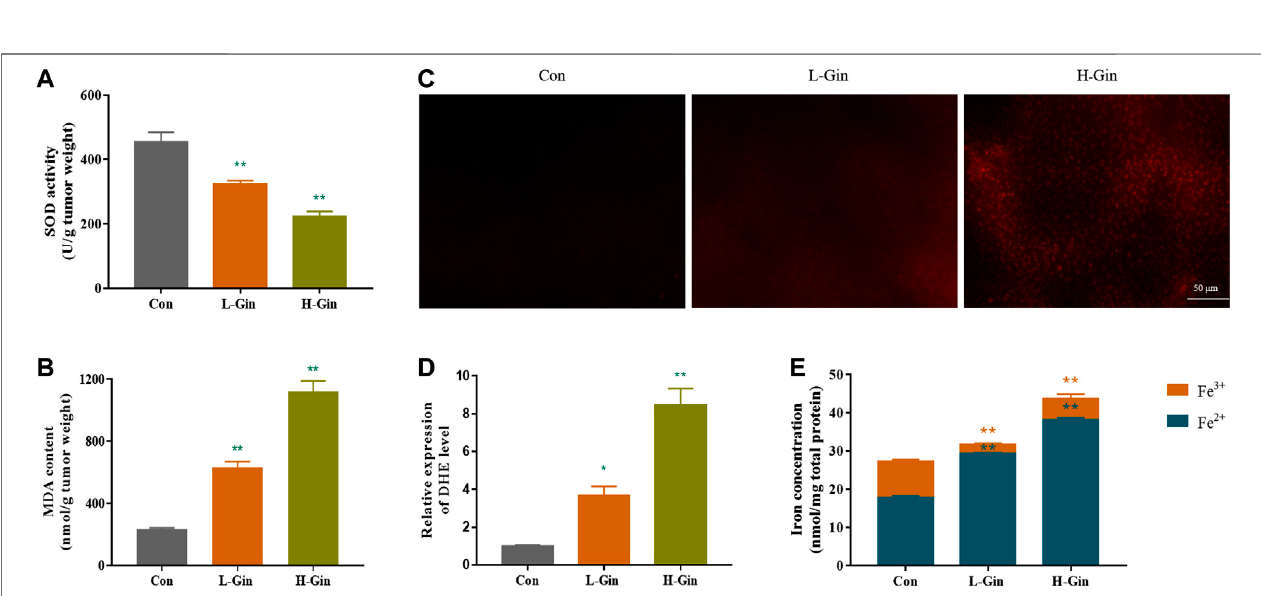
FIGURE2| 6-Gingerol enhancestheaccumulationofROSandironintumor. (A) Theactivity ofSODintumor tissues; (B) ThecontentofMDAintumor tissues; (C) The ROS fl uorescence (DHE) of tumor tissues; (D) The histogram of ROS content of tumor tissues; (E) The iron concentration in tumor tissues. Con: control, L-Gin: 0.25 mg/kg/day 6-Gingerol, H-Gin: 0.5 mg/kg/day 6-Gingerol. Compared with the control group,* p < 0.05, ** p < 0.01. Data are expressed as mean ± SD ( n (cid:2) 3).